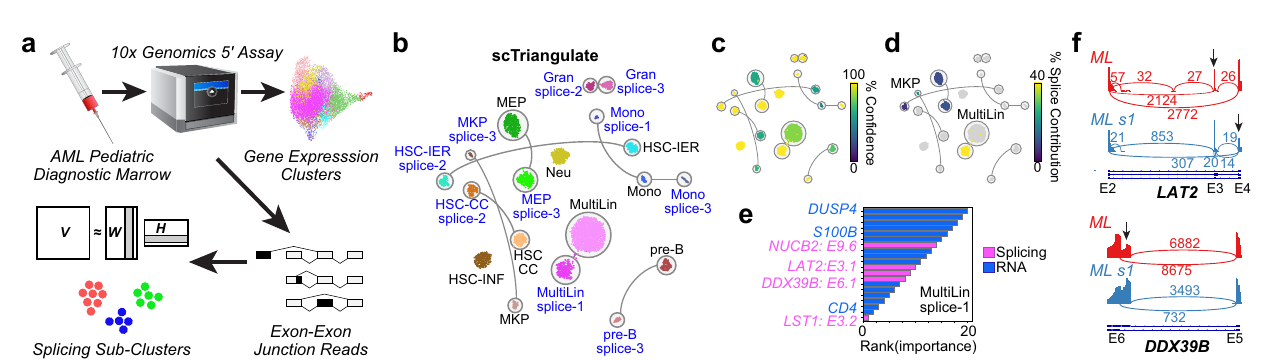
Fig. 7 | Resolution of splicing-de fi ned cancer cell states. a Overview of the strategy for identifying initial splicing-de fi ned subsets, from a diagnostic pediatric AML bone marrow sample pro fi led using the 10× Genomics 5 ′ library chemistry. Initial clusters were de fi ned using the software ICGS2 from gene expression mea- surements and k=3 sub-clusters from non-negative matrix factorization (NMF) analysisofpercent-spliced-in(PSI)values. b UMAPofAMLcellsfromneighborhood component analysisofAML geneexpressionand splicing,guidedby scTriangulate